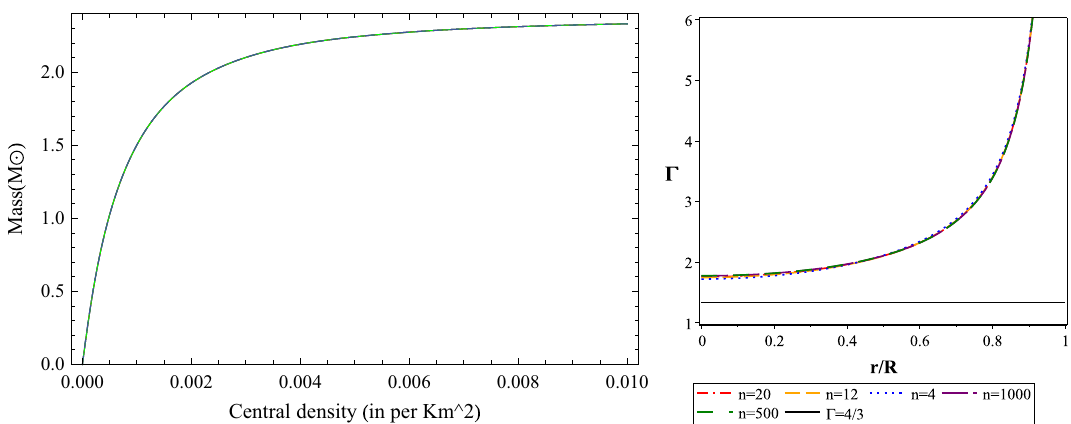
Fig. 6 Variation of the mass M (cid:9) with respect to the central density ( ρ 0 ) (left) and Variation of the adiabatic index ( (cid:17) ) (right) with respect to the radial coordinate ( r / R ). For purpose of plotting this figure , the numerical values of the constants for different parameters n are mentioned in